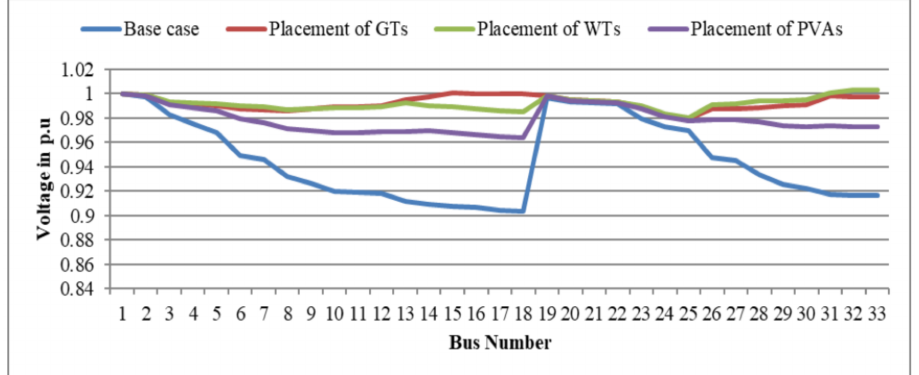
Figure 6. Voltage profile of 33 bus test system with optimal allocation of GTs, WTs, and PVAs placed in DS.